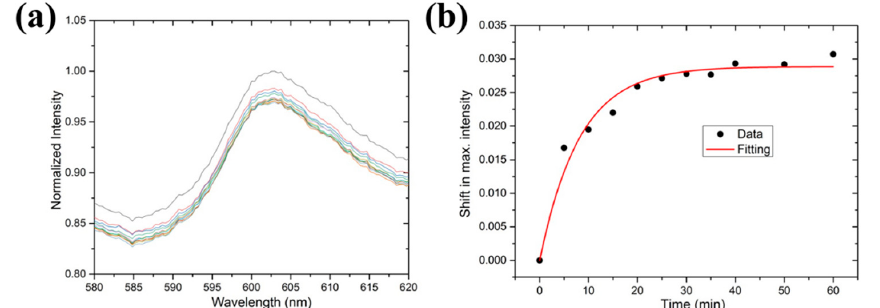
Figure 6. ( a ) The normalized spectra of BSA binding to the sensor surface at different time points. ( b ) The shifts in the maximum intensity at different time points. The binding kinetics were exponentially fitted to obtain the affinity.